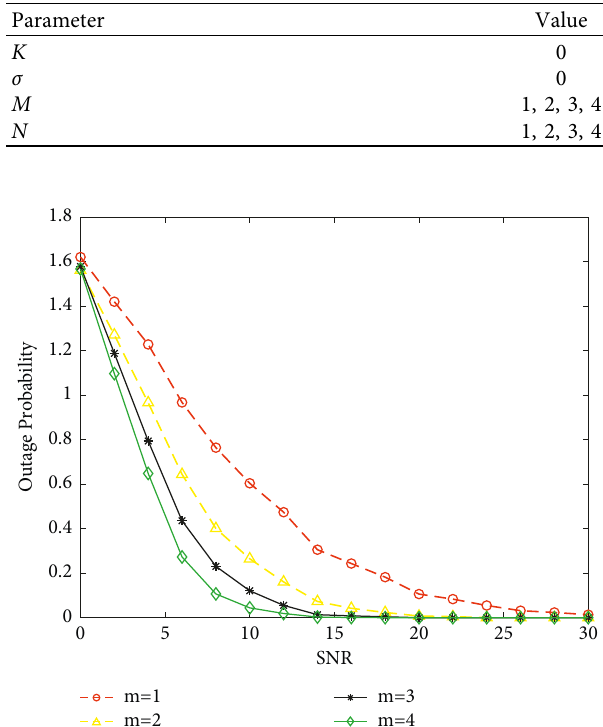
Table 1: Simulation parameters.